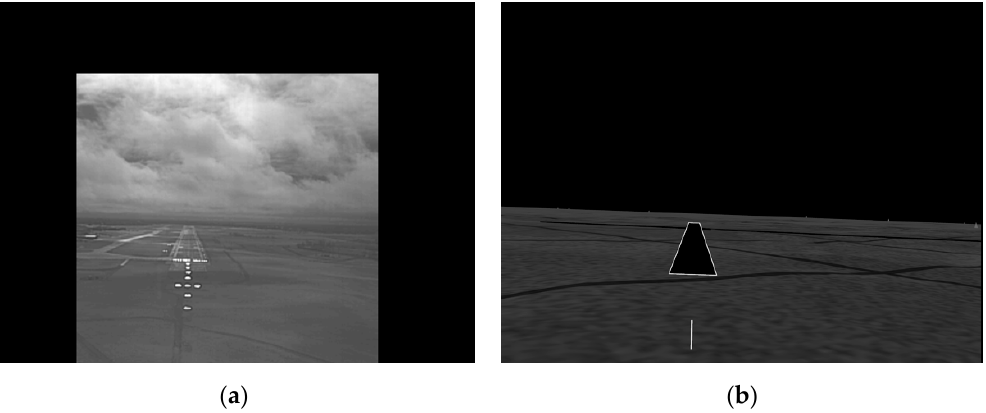
Figure 1. An example of ( a ) enhanced vision system (EVS) and ( b ) synthetic vision system (SVS) image frames.